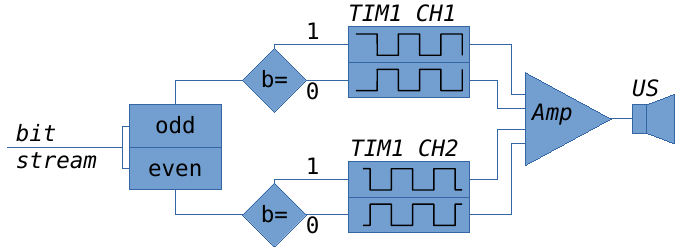
Figure 1. The diagram of QPSK modulation process implemented with the use of hardware